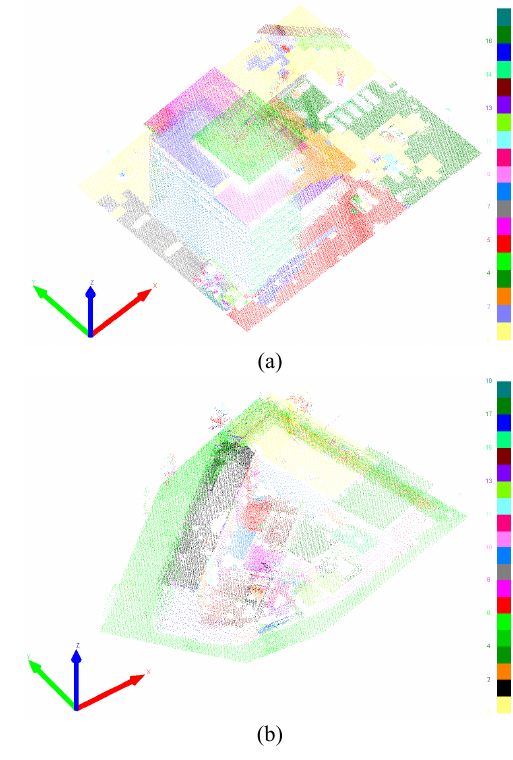
Figure 6. The detected PDSM structure lines for